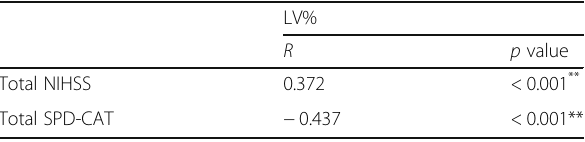
Table 7 Correlation between total NIHSS and total SPD-CAT with LV% LV% R p value Total NIHSS 0.372 < 0.001 ** Total SPD-CAT − 0.437 <